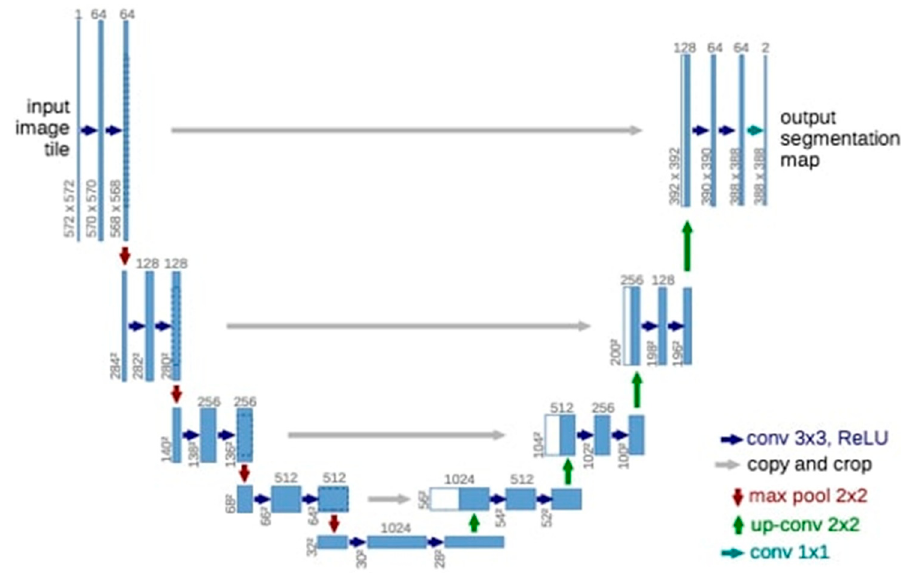
Figure 2. The 3D U-Net architecture. Blue boxes represent feature maps. The number of channels is denoted above each feature map.